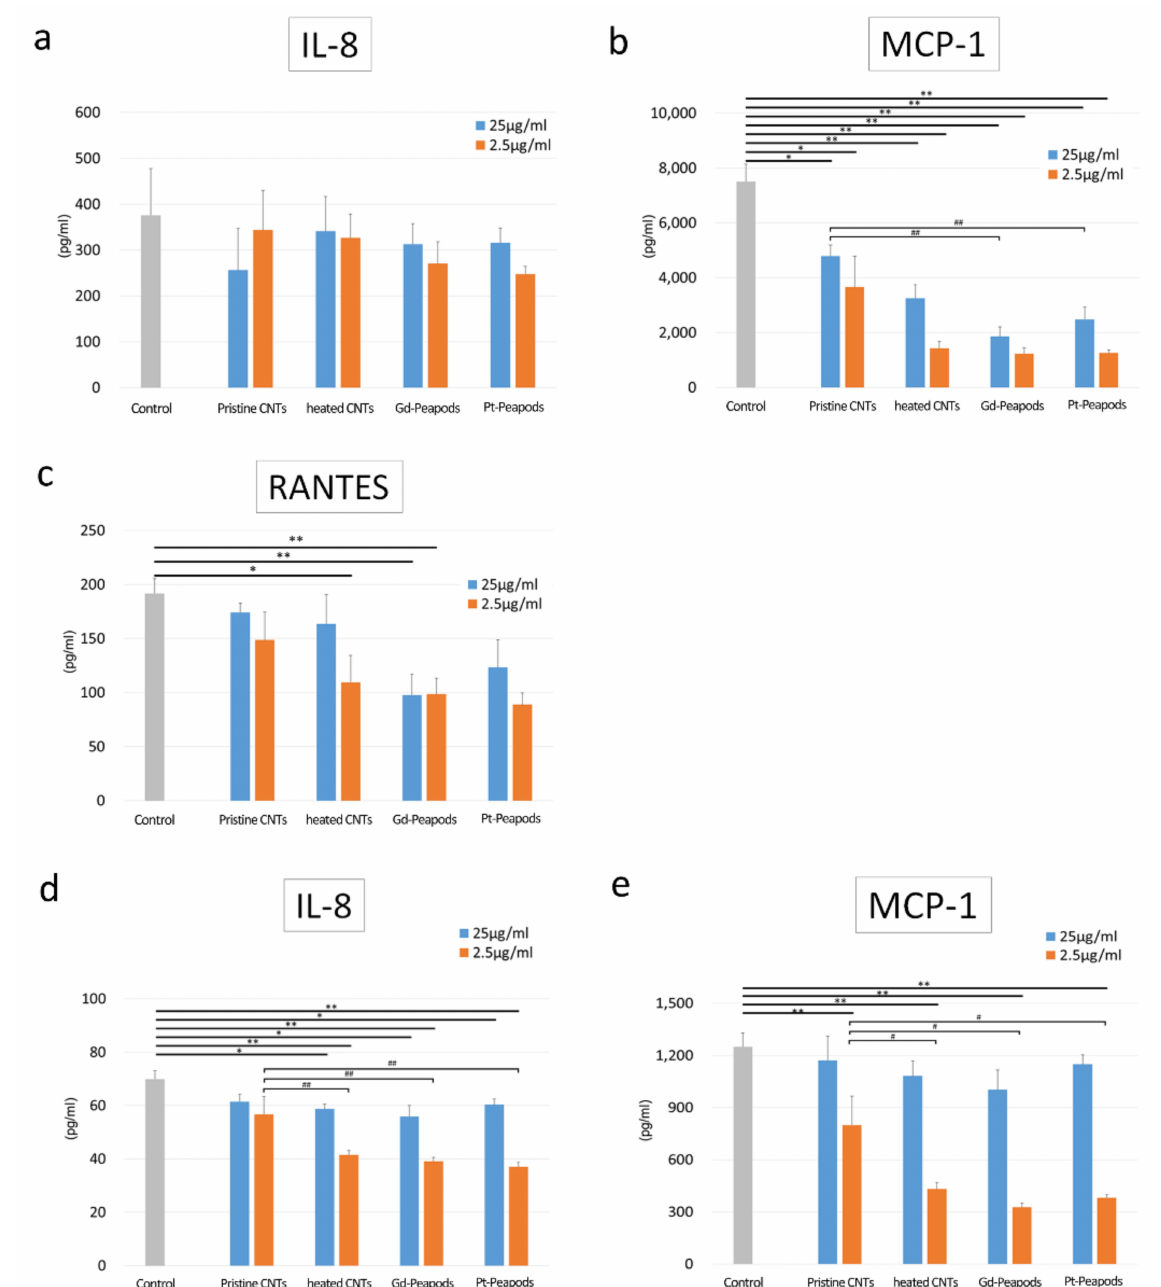
Figure 3. Cytokine secretion assay for lung-related cells MESO-1 and A549: ( a – c ) MESO-1 cells. ( d , e ) A549 cells. Mean ± S.E. ( n = 4). * p < 0.05, ** p < 0.01 (Compared to control), # p < 0.05, ## p < 0.01 (Compared to each